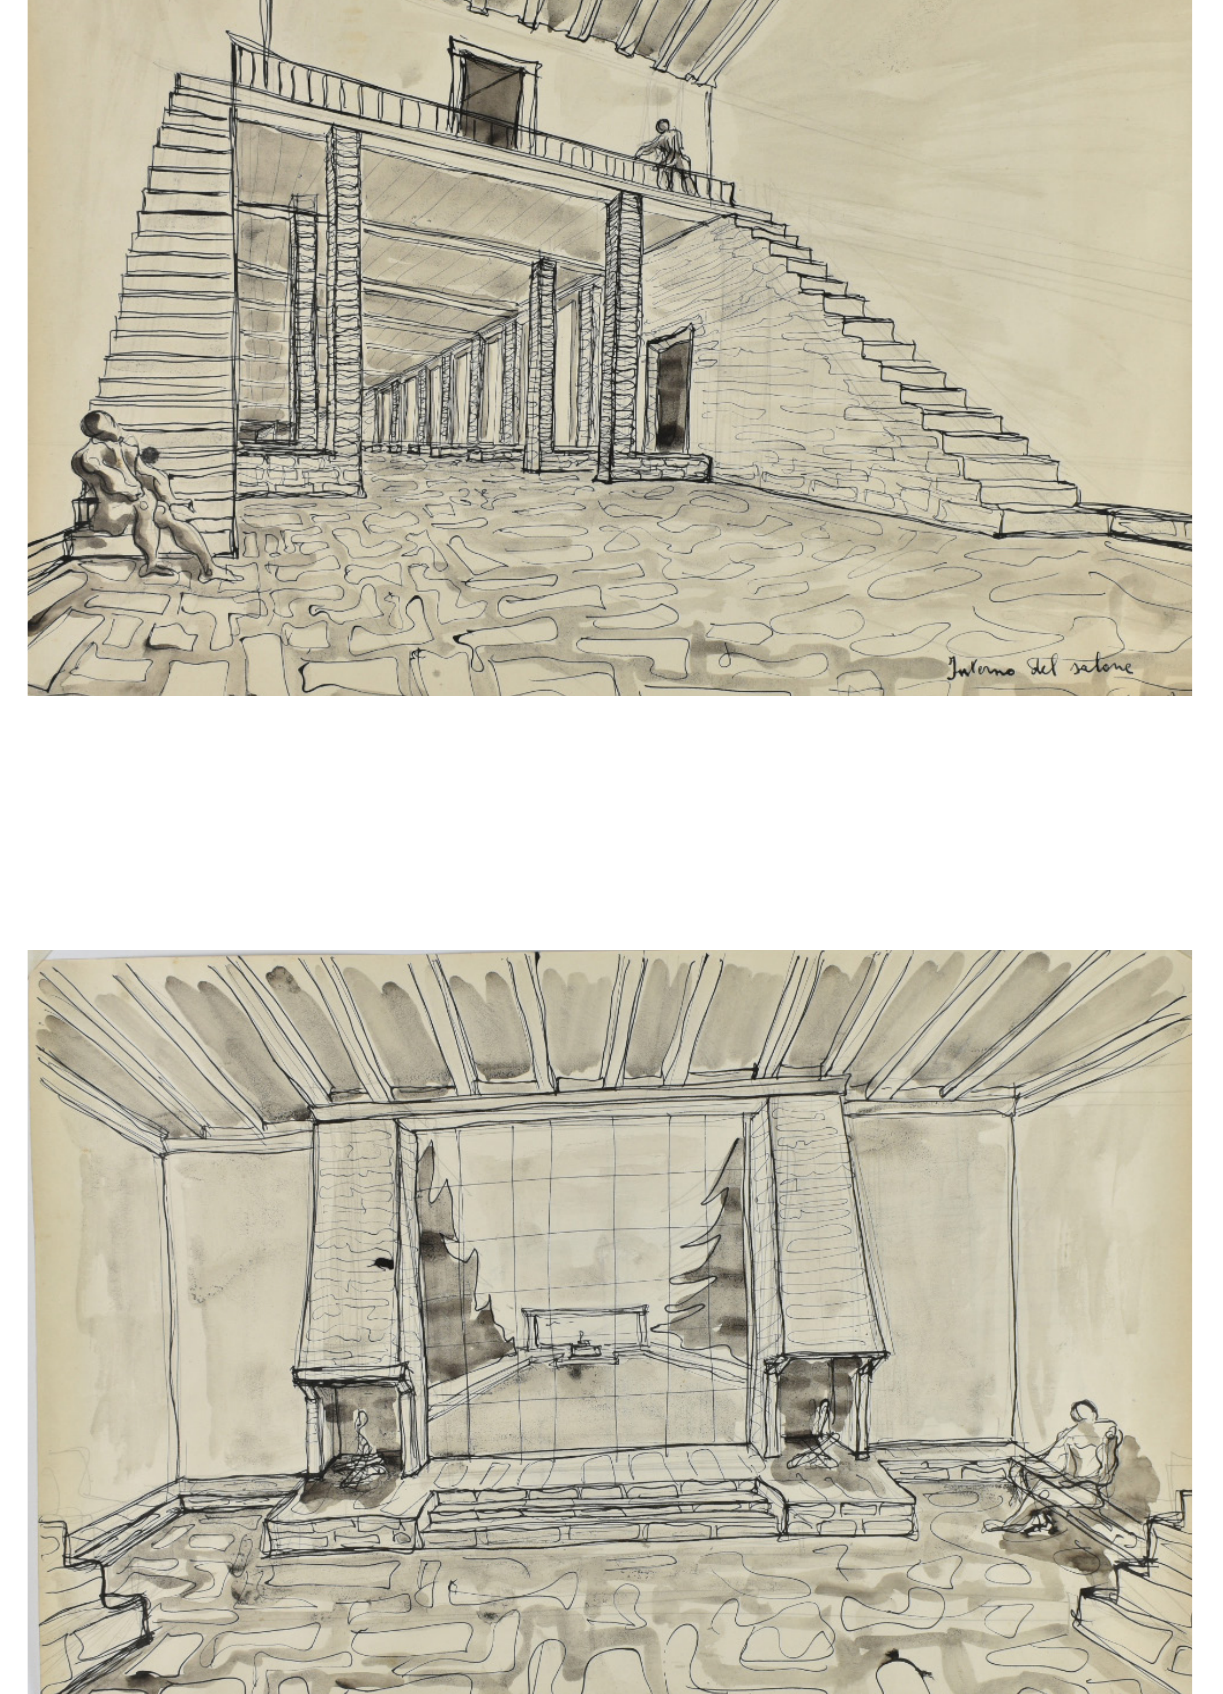
IMG.4: internal view of the “cells”, sketch, CSR; IMG.5: in- ternal view of the hall, sketch, CSR; IMG.6: view of the en- trance, sketch, CSR; IMG. 7: detail of the hall, sketch,